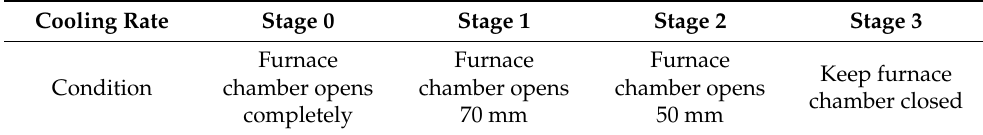
Table 3. Cooling rate during multiple firing.